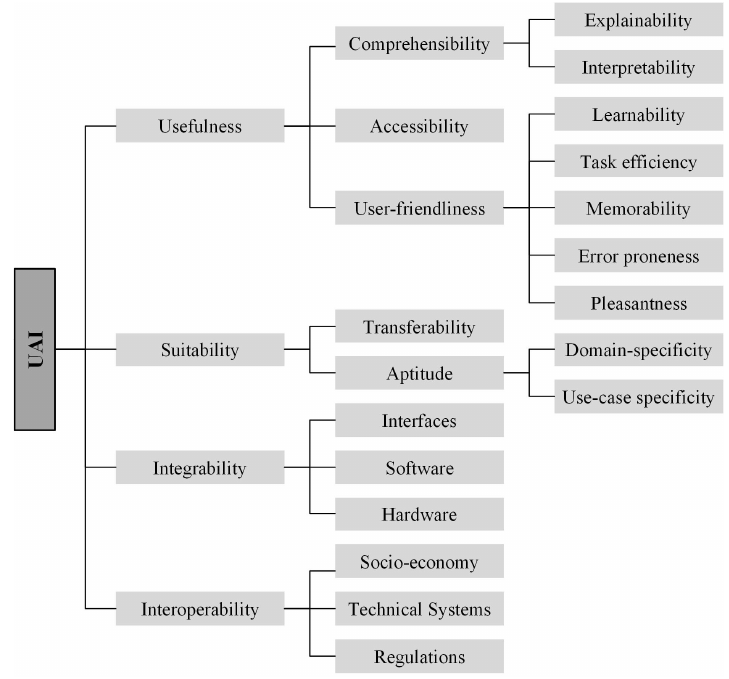
Figure 4. Anatomy of the usable artificial intelligence (UAI) paradigm.